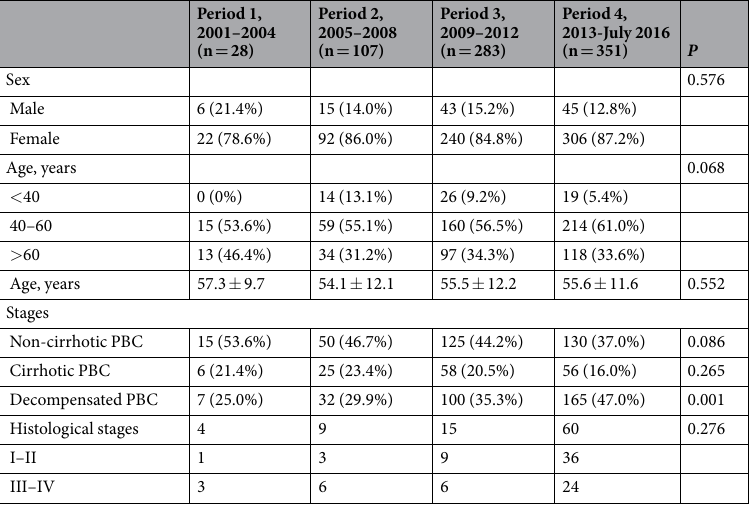
Table 1. Gender, age and stage distribution of PBC from January 2001 to July